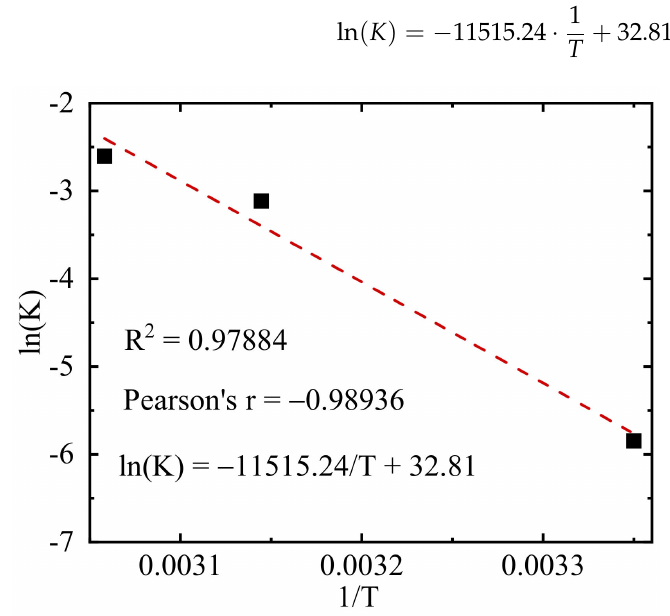
Figure 8. The relationship between 1/ T and ln( K